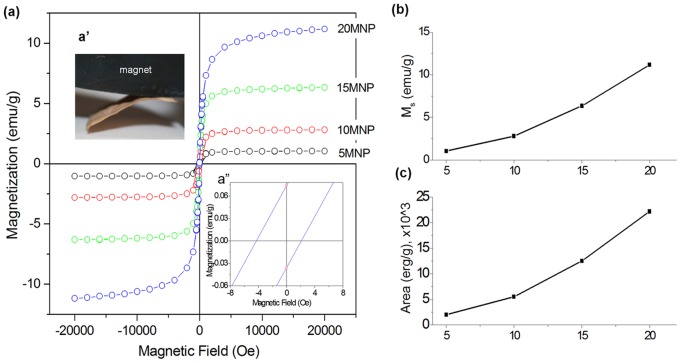
Magnetic properties of the nanocomposite nanofiber scaffolds.(a) Magnetization curve as a function of an applied magnetic field, measured with SQUID magnetometry, showing a hysteresis loop. Inset (a′) shows optical view of nanofiber samples attracted to a magnet. Inset (a″) shows magnetization behavior at low magnetic field, revealing coercivity (Hc) and remnant magnetization value (Mr). The magnetic behavior was typical of weak ferromagnetic or superparamagnetic materials. (b) Saturation magnetization, Ms, and (c) integrated loop area, measured from the magnetization curves. Increasing MNP content increased the Ms and loop area.